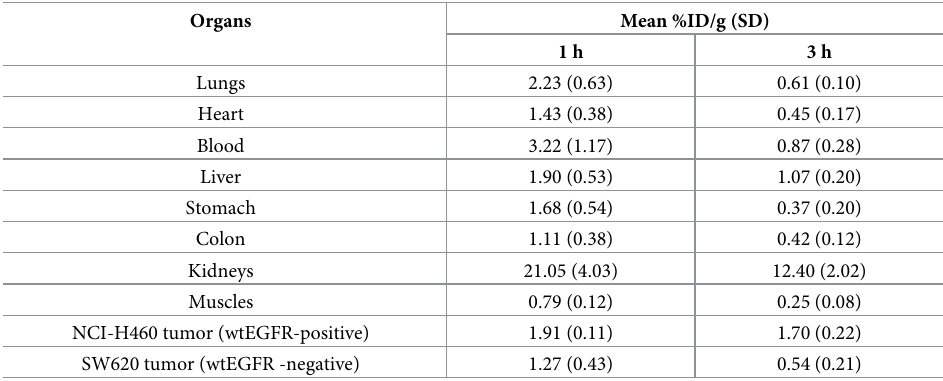
Table 1. Biodistribution data 1 and 3 h after injection of Tc-99m SYPIPDT-ECG-TAMRA in mice bearing NCI-H460 and SW620